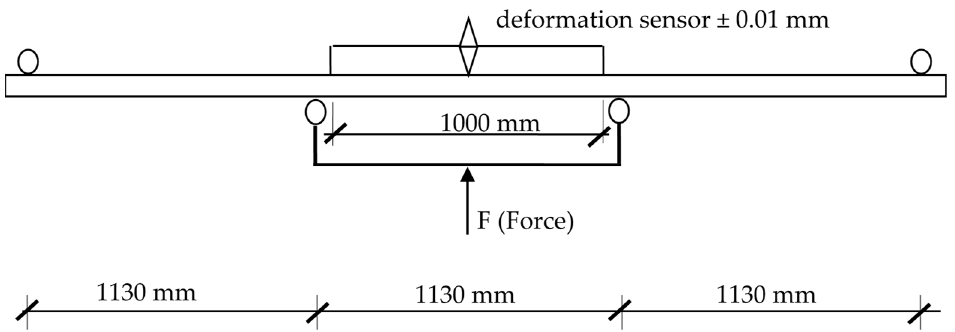
Figure 3. The diagram for loading of bonded beams.